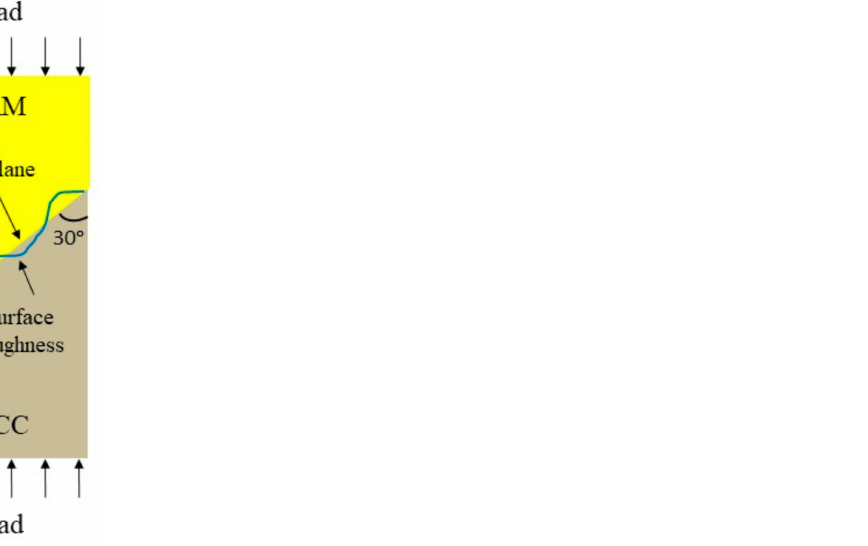
Figure 8. Shear failure at the bonding zone between the GRM and the rough OPCC substrate surface.